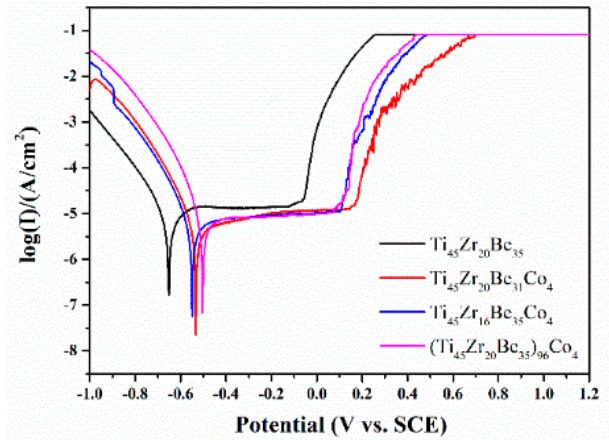
Figure 15. Potentiodynamic polarization curves of the Ti 45 Zr 20 Be 35 , Ti 45 Zr 20 Be 31 Co 4 , Ti 45 Zr 16 Be 35 Co 4 , and (Ti 45 Zr 20 Be 35 ) 96 Co 4 BMGs.